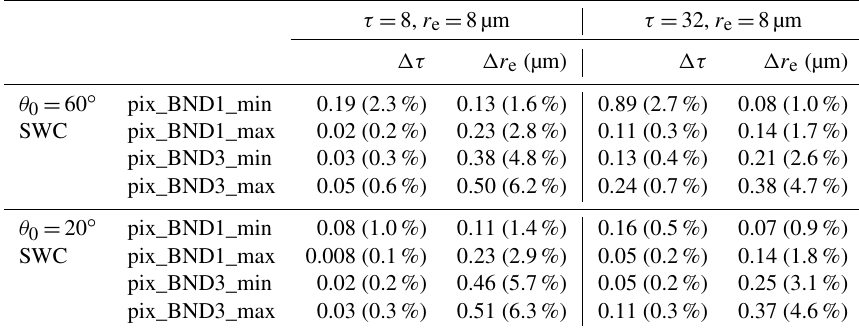
Table 3. Errors of COT and CDR for typical shallow warm cloud ( τ = 8 or 32, r e = 8µm).